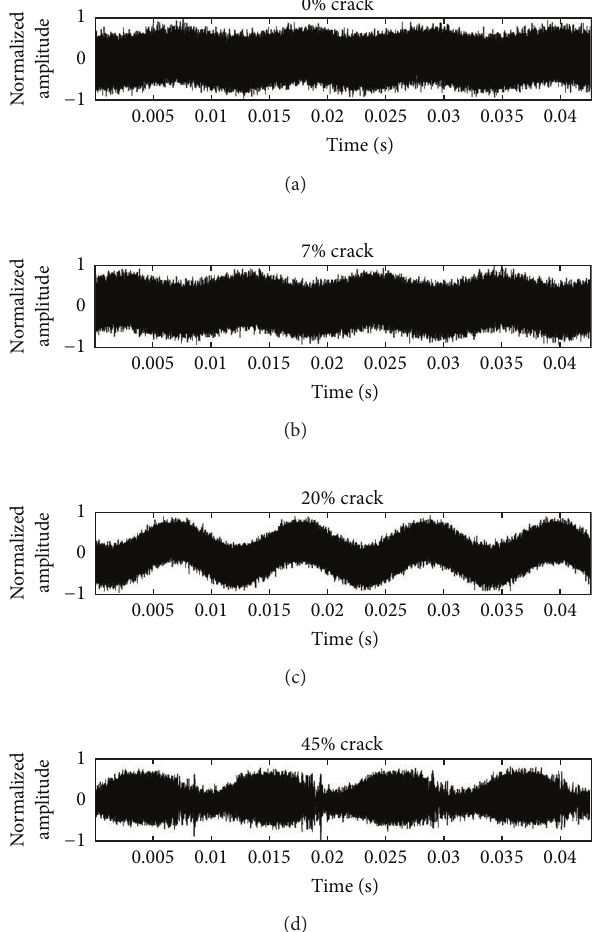
Figure 2: The experimental data excerpt (8192 samples, sampling frequency 192kHz) used in the ZAM analysis for the uncracked, 7%, 20%, and 45% of the crack depth cases ((a) to